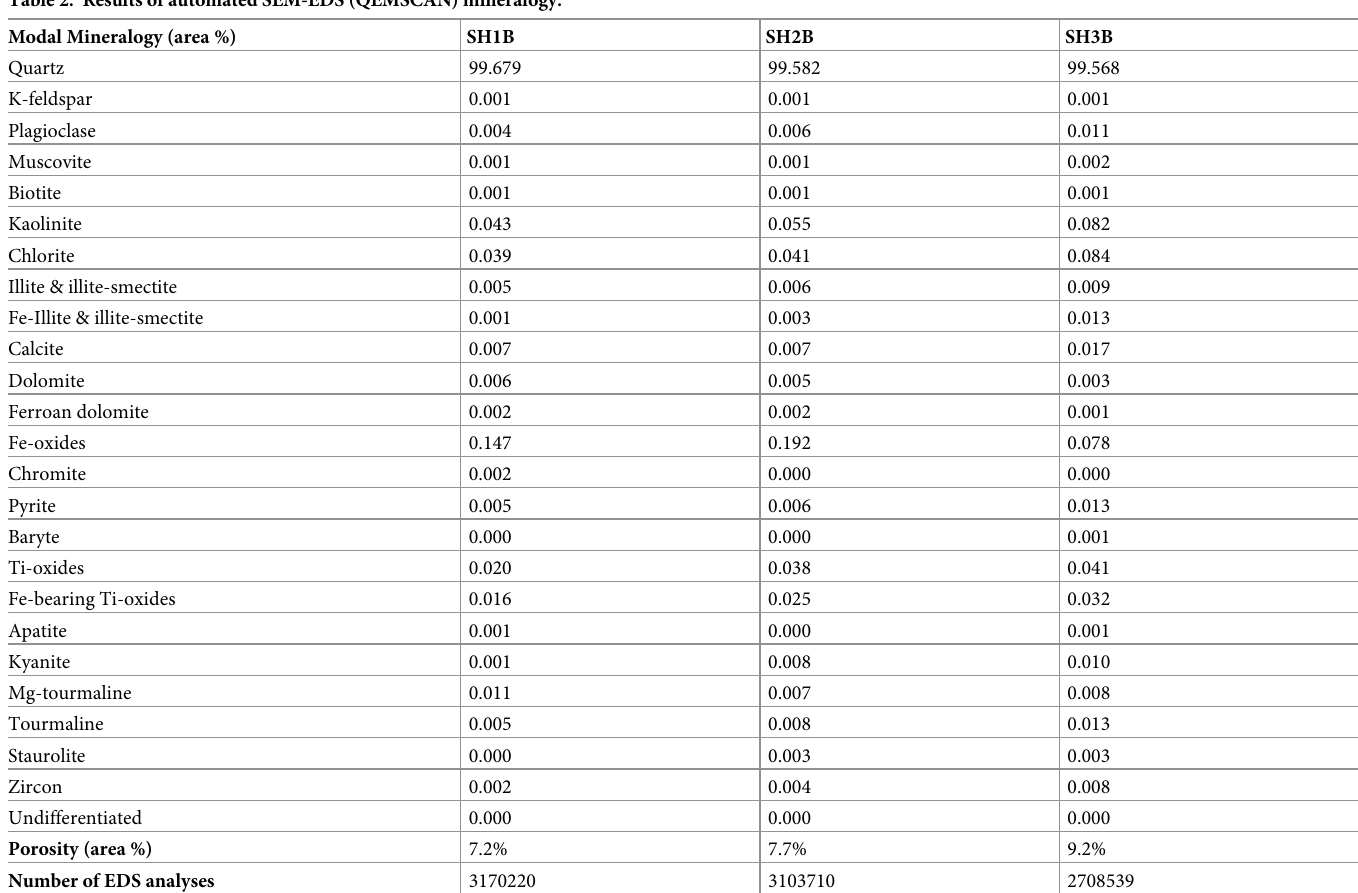
Table 2. Results of automated SEM-EDS (QEMSCAN)